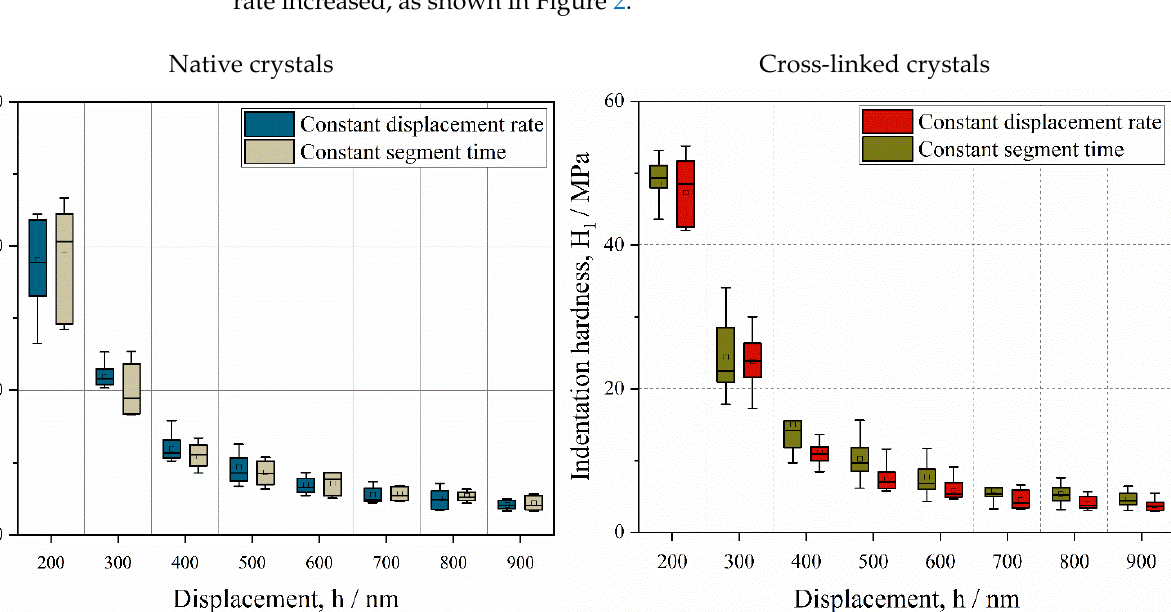
Figure 6. Indentation hardness of the prismatic faces of native ( left ) and cross-linked ( right ) crystals as a function of the depth and indentation displacement rate. The indentation rate of the constant-displacement-rate mode was 180 nm/s over the whole penetration range, while the indentation rate of the constant-segment-time mode increased from 364 nm/s at a penetration depth of 200 nm to 1636 nm/s at a penetration depth of 900 nm.